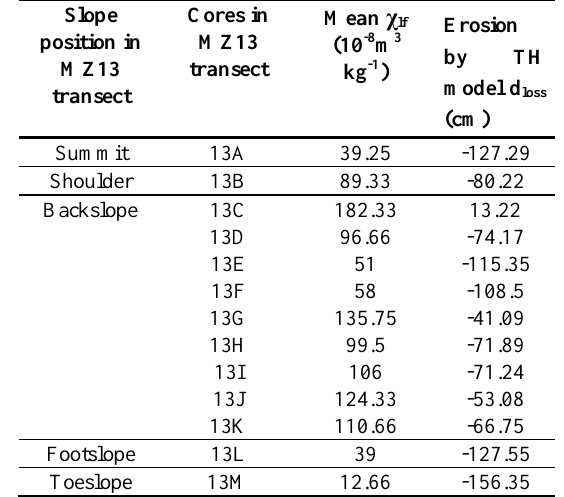
Table 3. Soil loss in different soil profiles after homogenization (in cm) in MZ13 transect